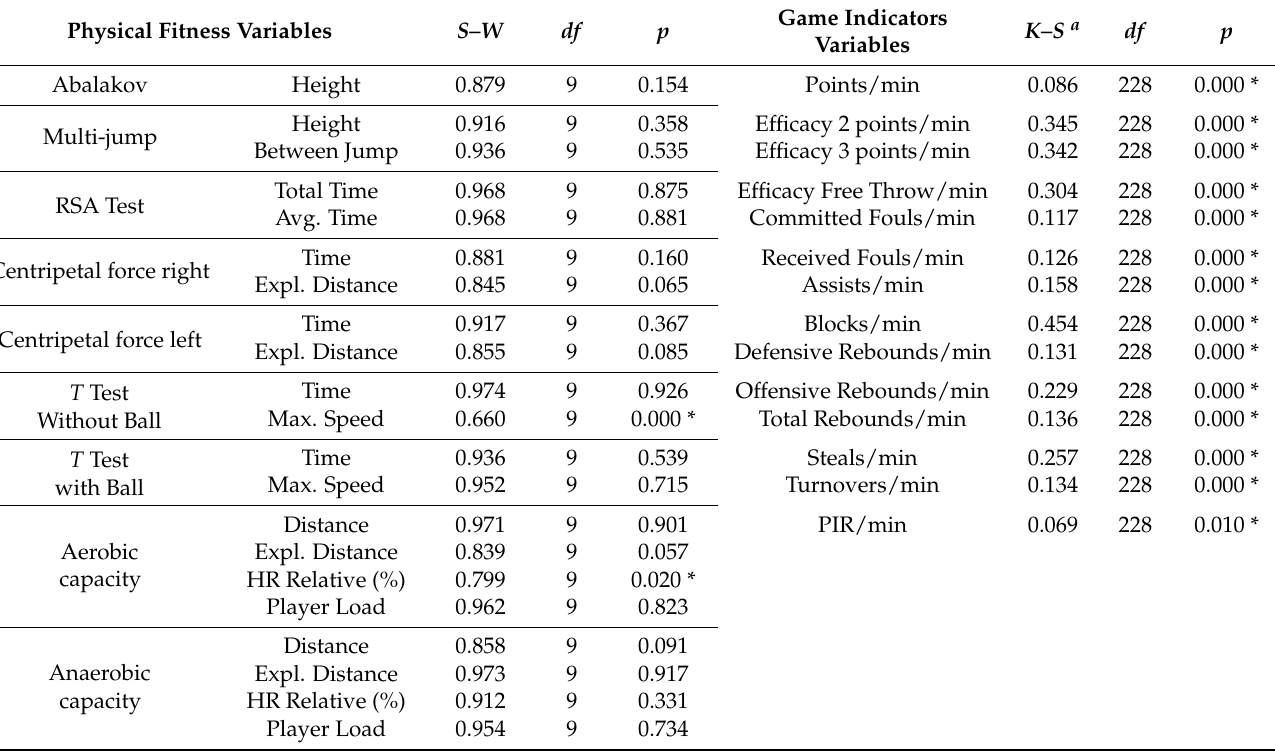
Table 1. Normality test